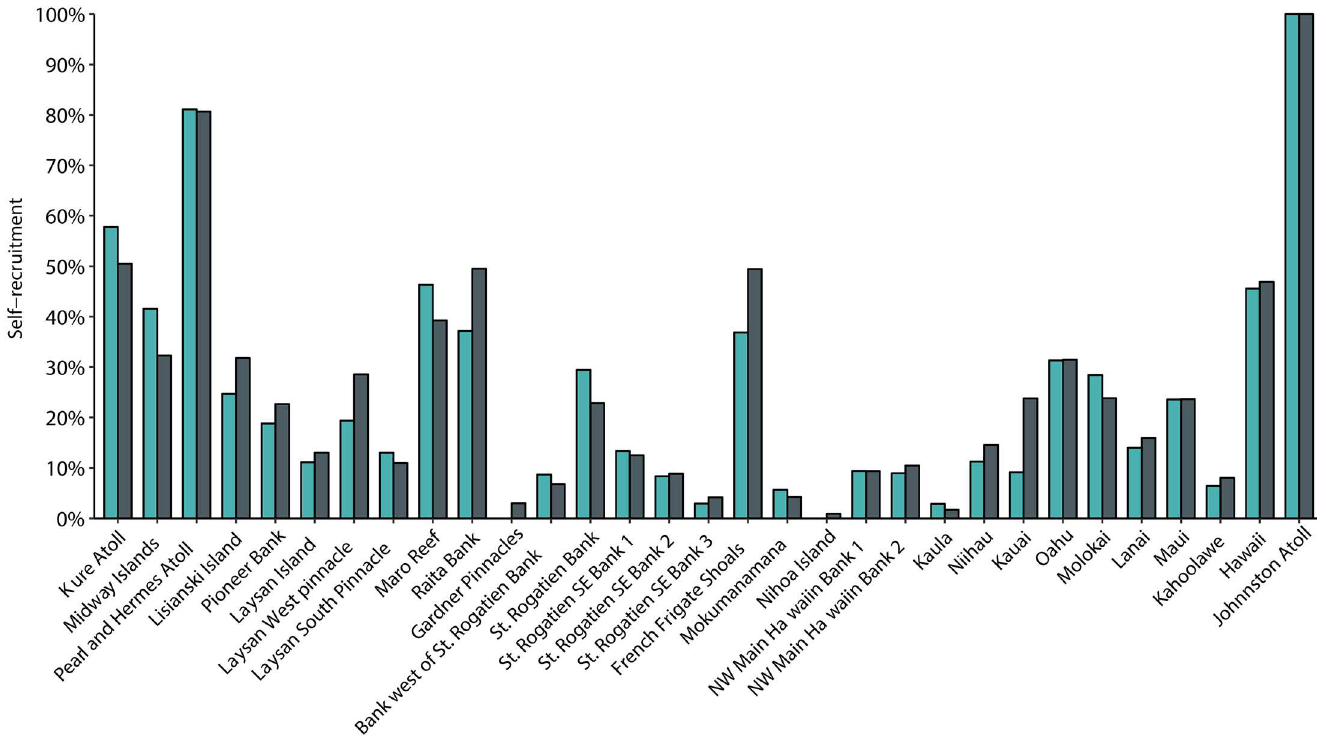
Fig 7. Island specific self-recruitment for the five-yearmodel run. Green bars show self-recruitment for particlesspawnedduringMay-June, gray bars show self-recruitment for year-round